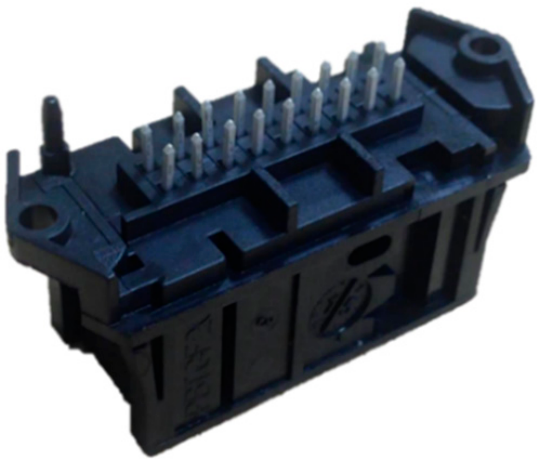
Figure 5. The 18-pin header was used in this study. The protrusion on the left is the reference peg. In measuring the positions of the pins from the side, the connector’s images were captured in two different orientations, as shown in Figure 6. This research only measured the first six pins of the three samples. Figure 6a shows the connector’s image when θ b 1 = 22 ◦ . On the other hand, Figure 6b shows the connector’s image when θ b 2 = 28 ◦ . By measuring d 1 and d 2 illustrated in Figure 4 and solving Equation (4), the deviation can be obtained, as listed in the rows marked by “side” for the three samples in Table 1. Further, the 2D VMM was used to measure the deviation from the bottom. The results are also listed in the rows marked by “bottom” for the three samples in Table 1 for comparison. The results in Table 1 are also illustrated in Figure 7, in which the combined uncertainty of 0.004 mm for the proposed method and the combined uncertainty of 0.006 mm for the 2D VMM were used to generate the error bars for the data in Table 1. As shown in Figure 7, both measurement results have the same trend, although most of the results corresponding to the same pins do not overlap. The finding is not surprising, because each of the methods measured different parts of the pins. Subtracting the data in the “bottom” row from the data in the “side” row for the three samples in Table 1 gives differences ranging from − 0.029 to +0.029 mm.